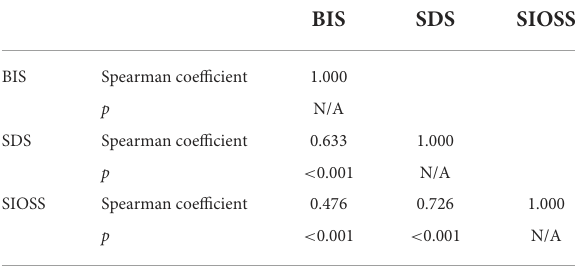
TABLE 2 Correlation matrix of the scores of BIS, SDS and